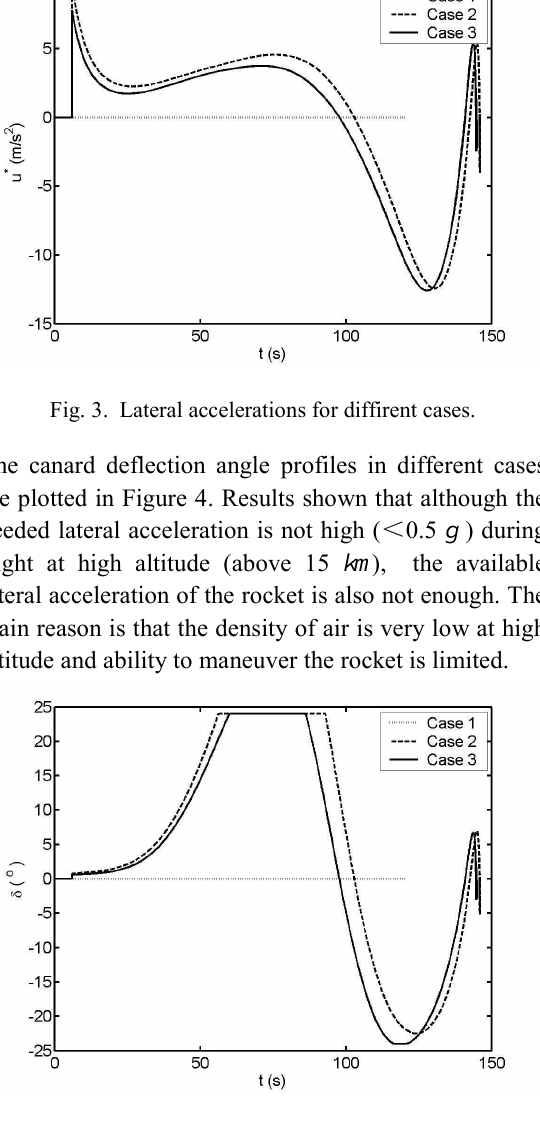
Fig. 4. Canard deflection angle